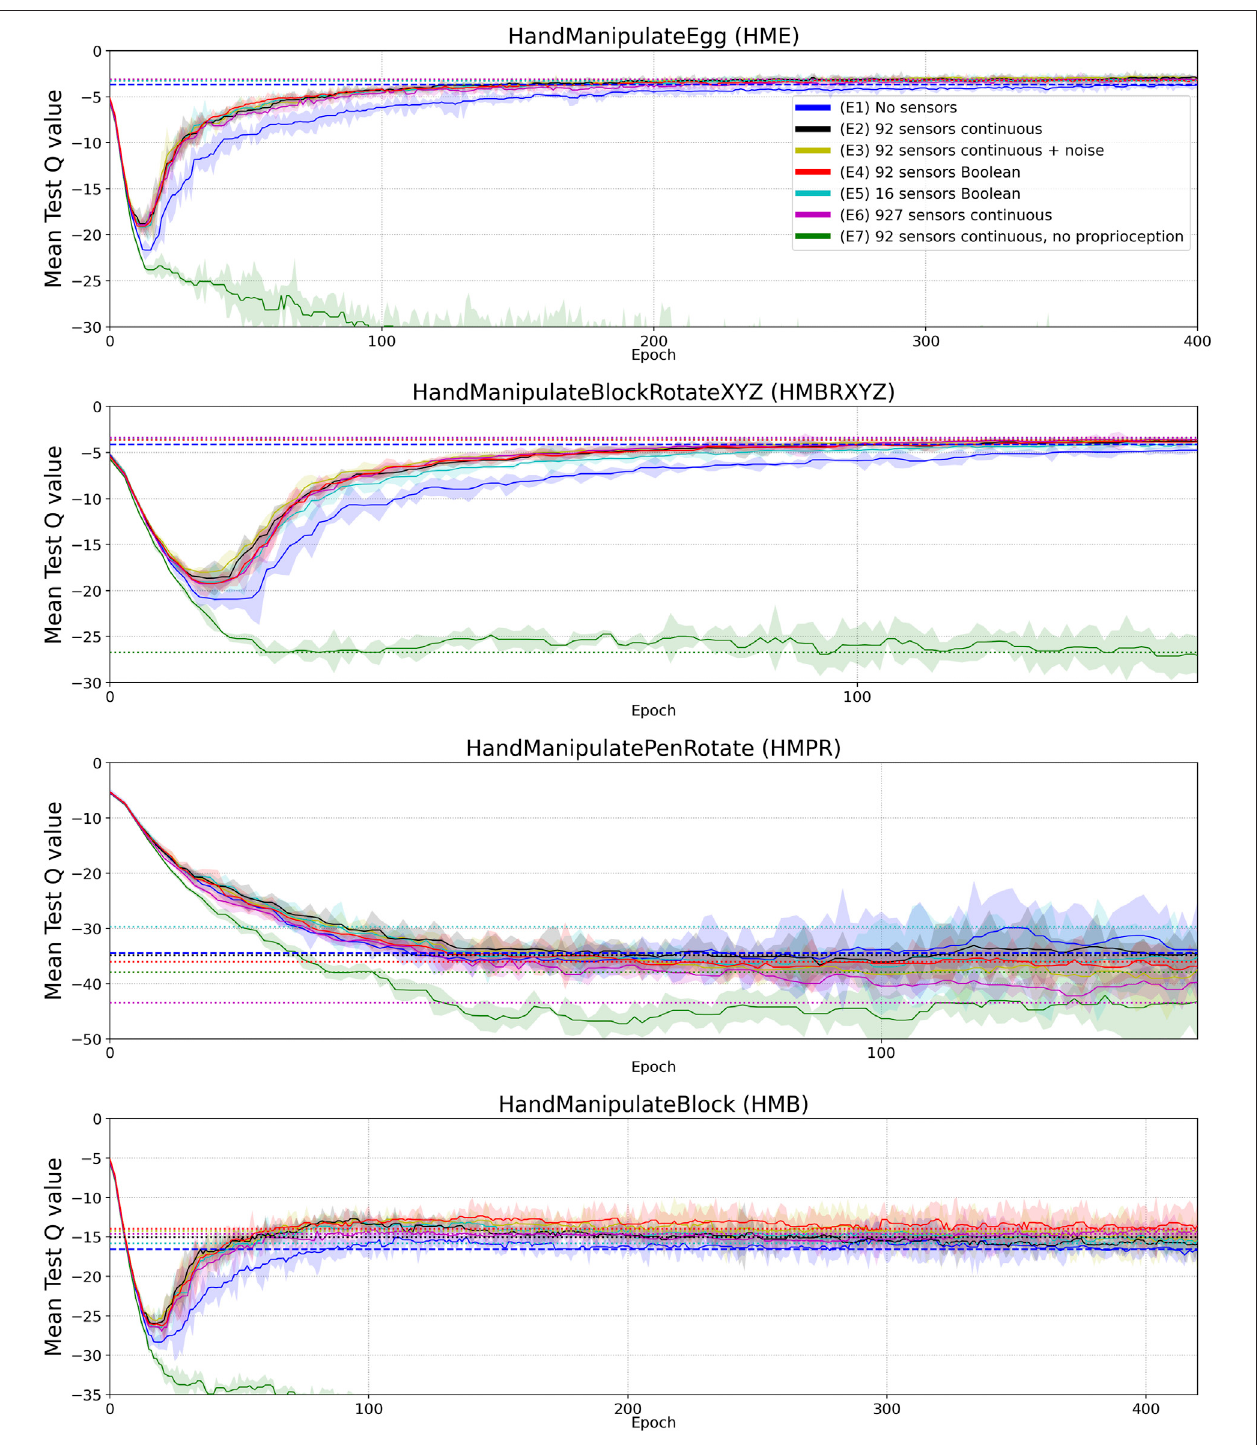
FIGURE 5 | Mean Q value curves (vertical axes) vs. training epochs (horizontal axes) for tasks HME, HMBRXYZ, HMPR, HMB and experiments E1-E7 (colored curves – see HME fi gure legend). See thefullversion ofthis fi gure in Appendix Figure A2 . Each curveshows themedian Q-valueacross fi vedifferenttraining trialswitha differentrandomseed.TheQ-valueineachtrainingtrialisthemeanof10testsaftereachtrainingepoch.Themediansmoothingwindowofplottedcurvesisequalto fi ve epochs. Shaded areas represent the interquartile range. Horizontal dotted lines highlight the mean-Q-value convergence level of corresponding (color) curves.